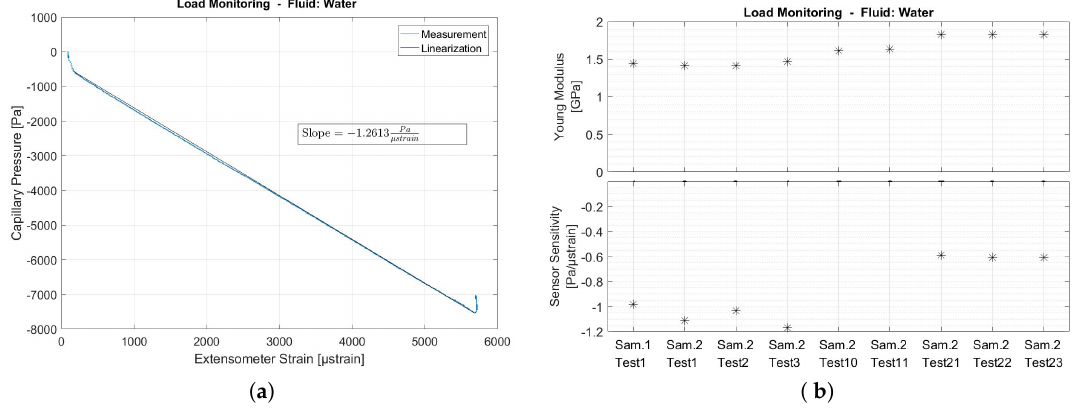
Figure 9. Tensile testing results: Load monitoring system with capillary filled with water is compared to extensometer strain measurements. ( a ) Capillary pressure is linear with respect to extensometer strain ( b ) Comparison of Young Modulus and strain sensor sensitivity of two samples and repeated testing on one tensile test sample. Raw data can be found in Appendix Figure